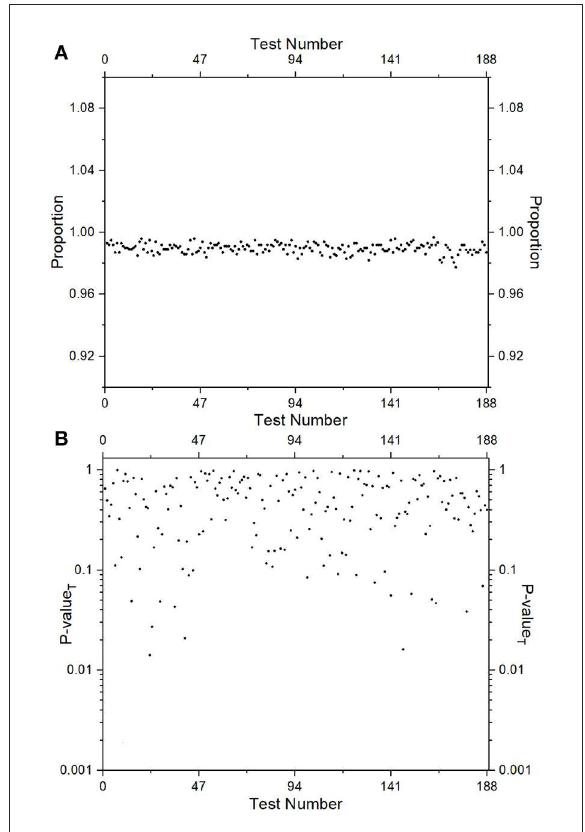
FIGURE2 Testing of pseudorandom sequences using NIST test suite: (A) Proportions and (B) p − value T